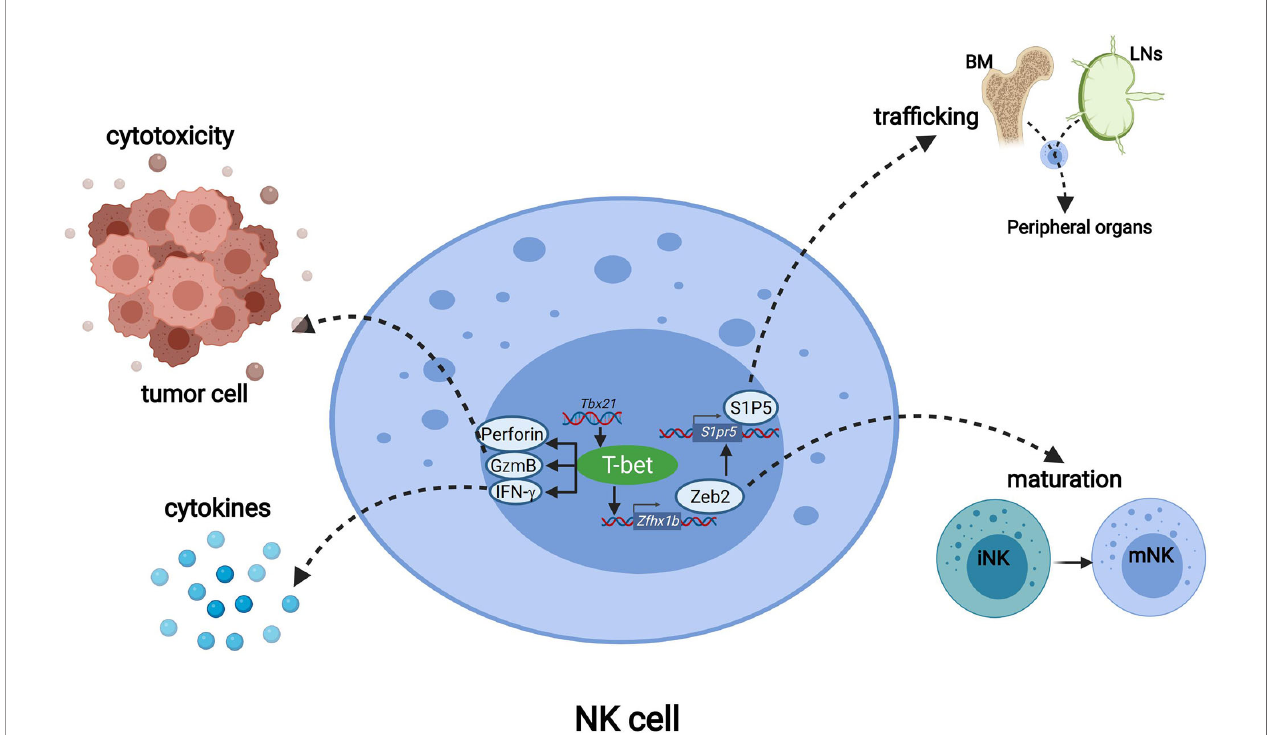
FIGURE 1 | The regulation of T-bet expression in NK cells. IFN- g binds to IFN- g R and regulates the expression of T-bet through JAK-STAT1 pathway. IL-12 induces T-bet expression independent of IFN- g through JAK-STAT4 pathway. IL15 activates PI3K-AKT-mTORC1signaling axis to promote the expression of T-bet, whereas Foxo1 downstream of mTORC2 can inhibit the expression of T-bet in NK cells. IL-21 can activate the JAK-STAT3 pathway, and the activated STAT3 combines with MyD88 to activate the downstream NK- k B pathway to up-regulate the expression of